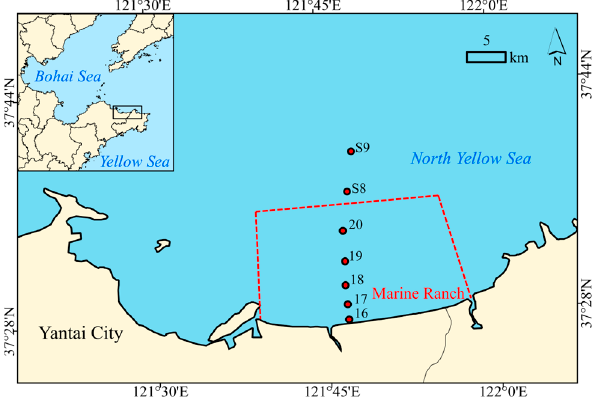
Figure 1. Study area and sampling sites.